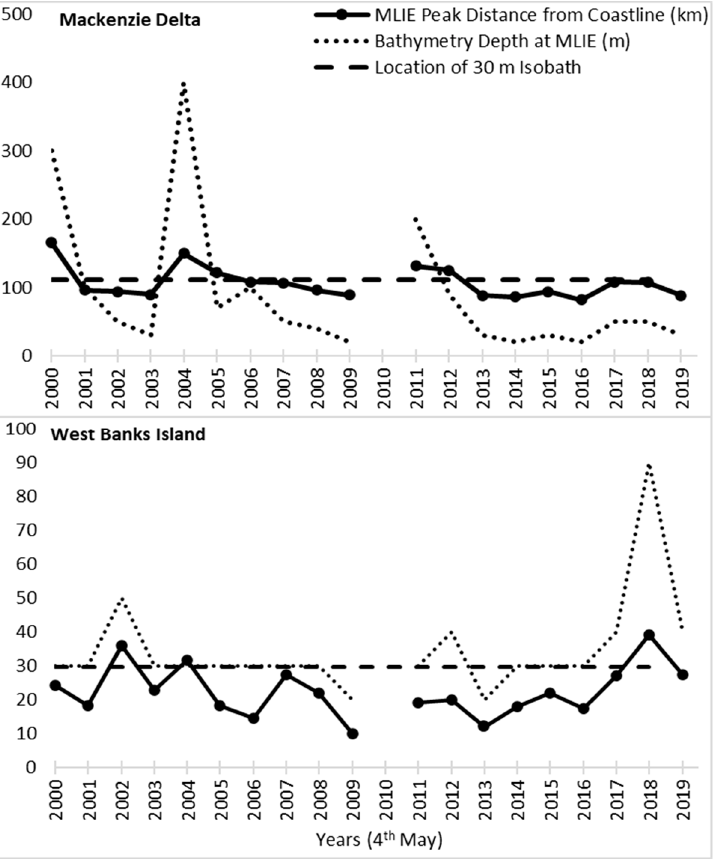
Figure 5. Bathymetric control at Mackenzie Delta and West Banks Island (refer to Figure 1 for bathymetry). Line plots show annual sequencing of MLIE distance from coastline with bathymetry depth achieved, relative to 30 m isobath. Key shows distance ( y -axis) of both MLIE and bathymetry depth achieved, relative to 30 m depth.